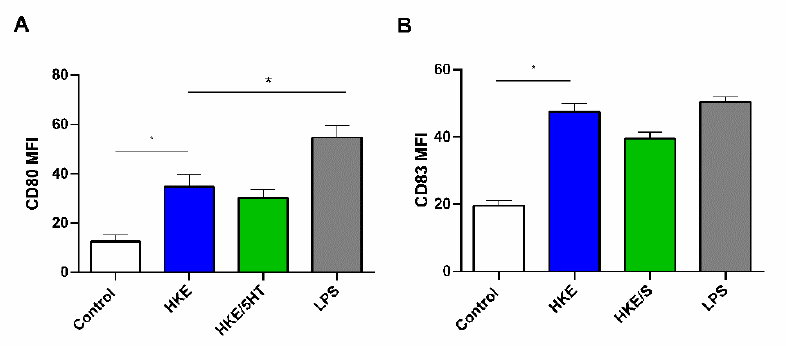
Figure 6. DC differentiation. CD80 ( A ) and CD83 ( B ) expression measured as mean fluorescence intensity (MFI), in DC untreated (Control), stimulated with LPS (positive control), or with 5HT-treated and untreated E. faecium NCIMB10415 (HKE/5HT and HKE) (* p < 0.05 ).